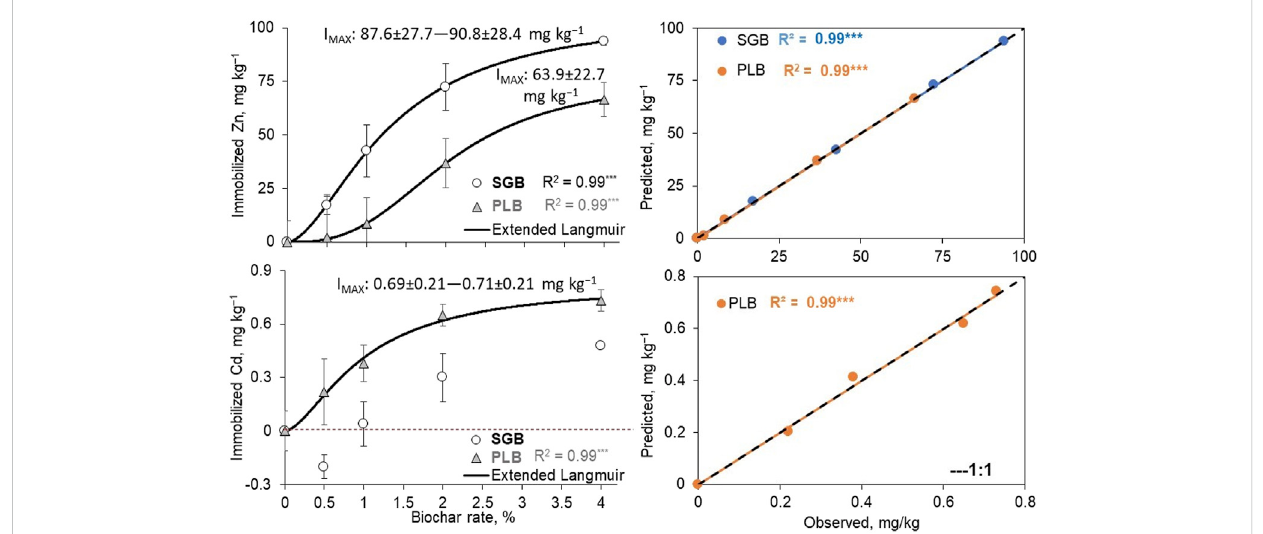
FIGURE 3 Extended Langmuir modelsused to predictthemaximumimmobilization ofheavy metals as afunction ofbiochar application rates(left), and plotof observed × predicted values from the fi tted models (right). No line means a non-signi fi cant fi t of the model. Bars represent the standard deviation of the mean ( n = 3). Points below the red dashed line (negative values) mean that heavy metal becomes more available than the control treatment (0% biochar application). I MAX = maximum immobilization for the fi tted model. Values followed by ± are the standard deviation. ***: p < 0.001. ExtendedLangmuiradsorptionisothermequation : y (cid:1) ( a * b * x ^ [ 1 − c ]) / ( 1 + bx ^ [ 1 − c